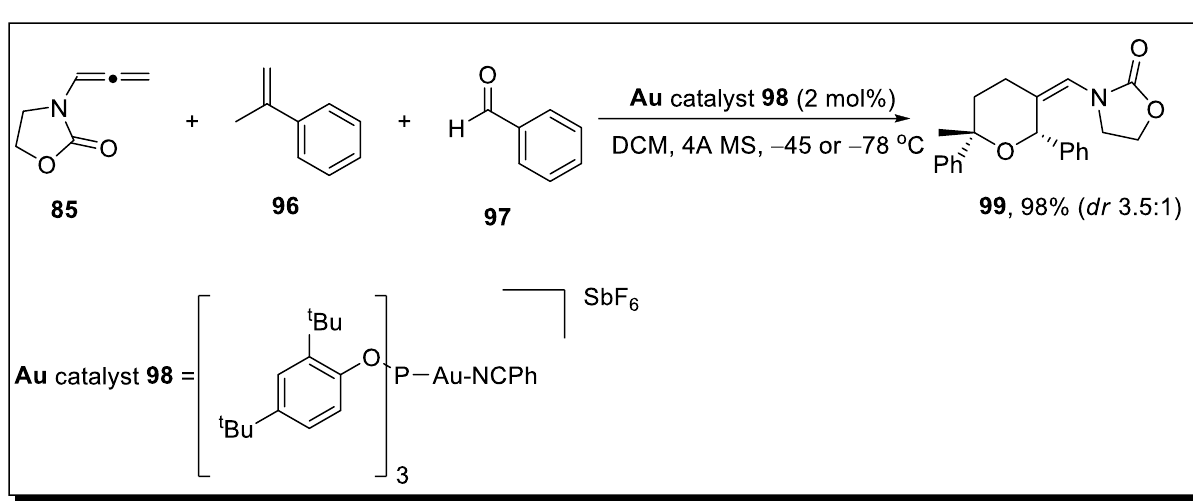
Scheme 30. Synthesis of tetrahydropyran 99 via [2+2+2] cycloaddition reaction.